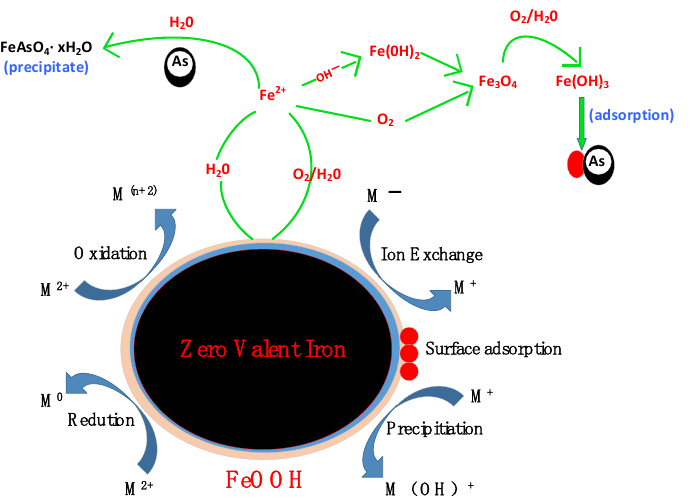
Figure 6. Schematic illustration of the mechanisms in the adsorption of As(V) and metal ions. F − is a stable form of fluorine, and its outer electron configuration is 2S 2 2P 5 , which is easy to bond with elements with empty orbitals through coordination bonds in solution.